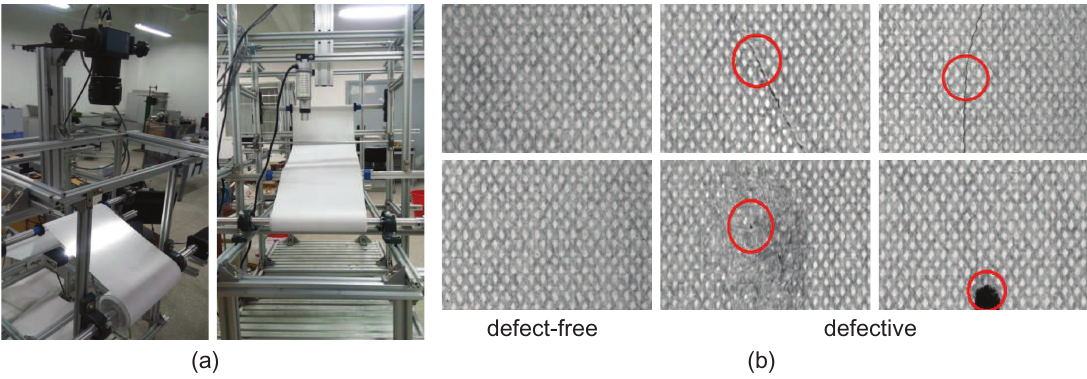
Figure 7. ( a ) The automatic optical inspection test bench utilized for fabric defect detection; ( b ) Defect-free and defective samples collected by the test